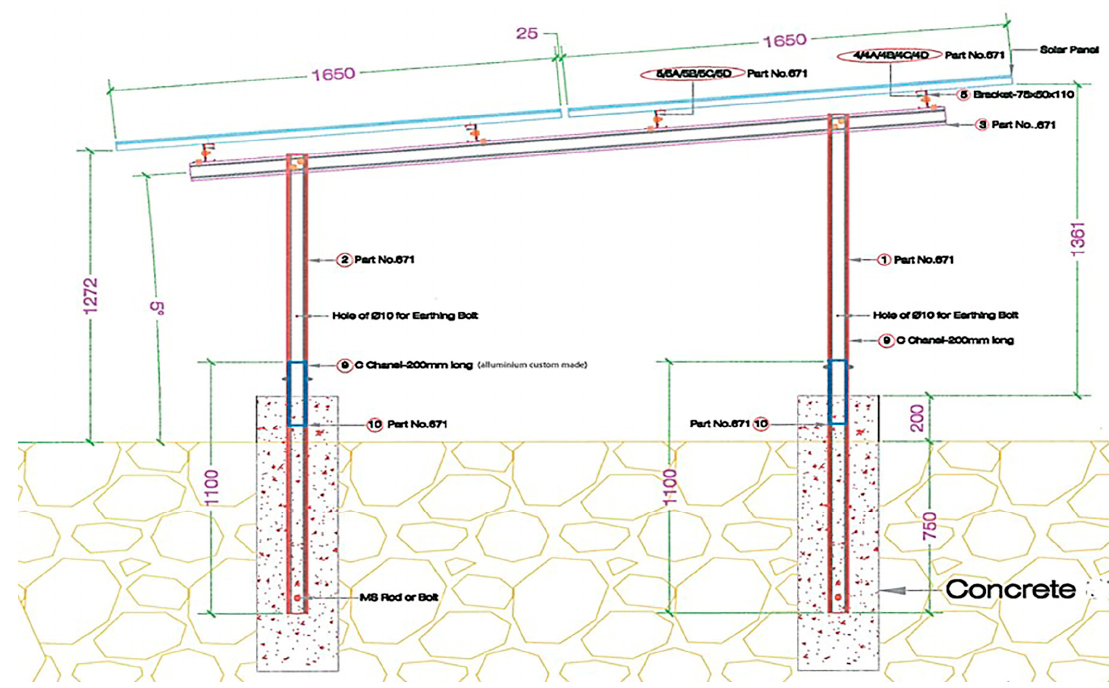
Figure 8. PV modules mounting structure with height distance from ground